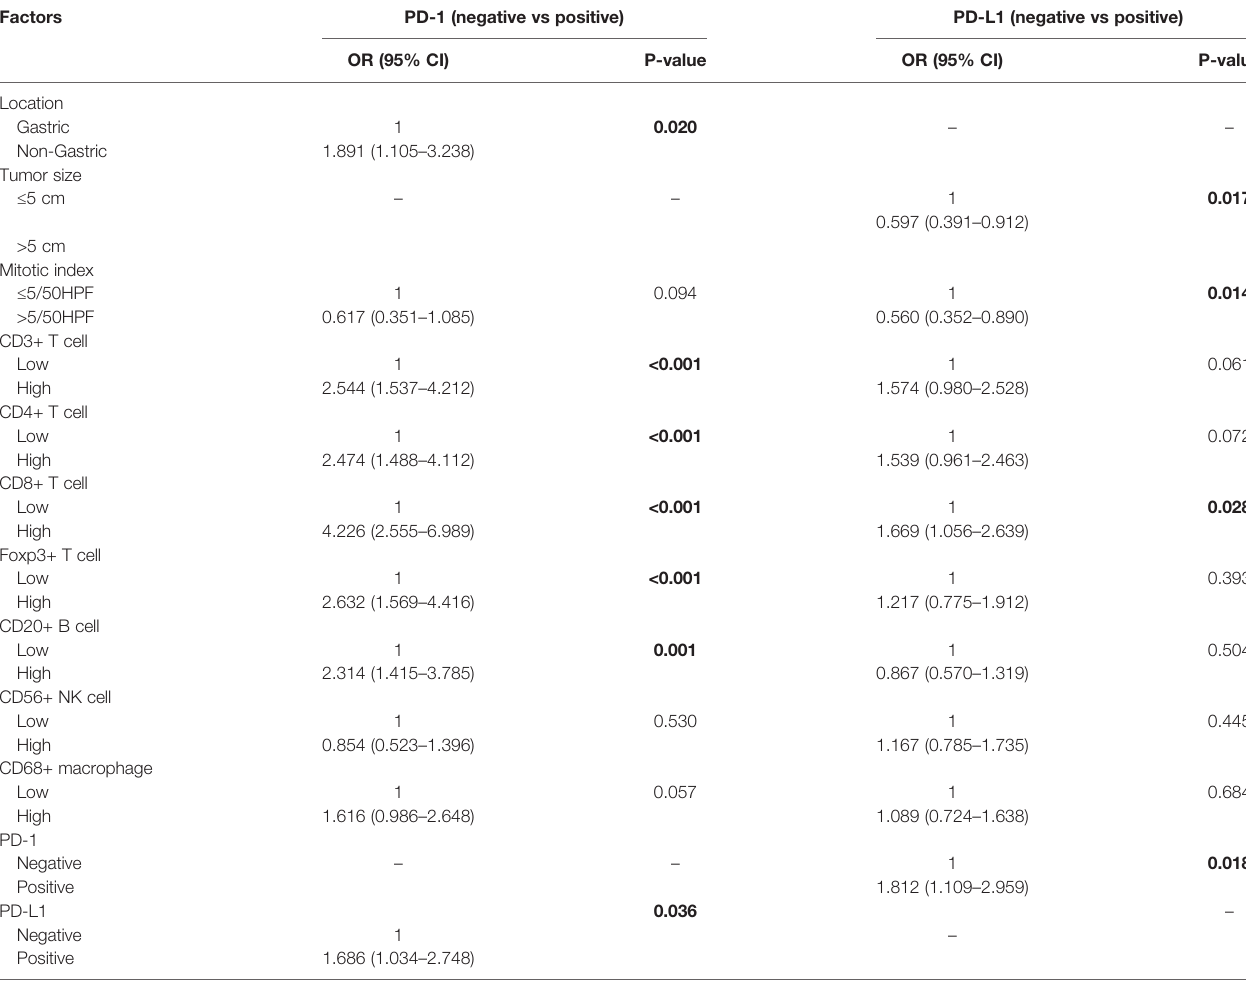
TABLE 3 | Multivariate analysis of the relationship between PD-1/PD-L1 expression and clinicopathological features.